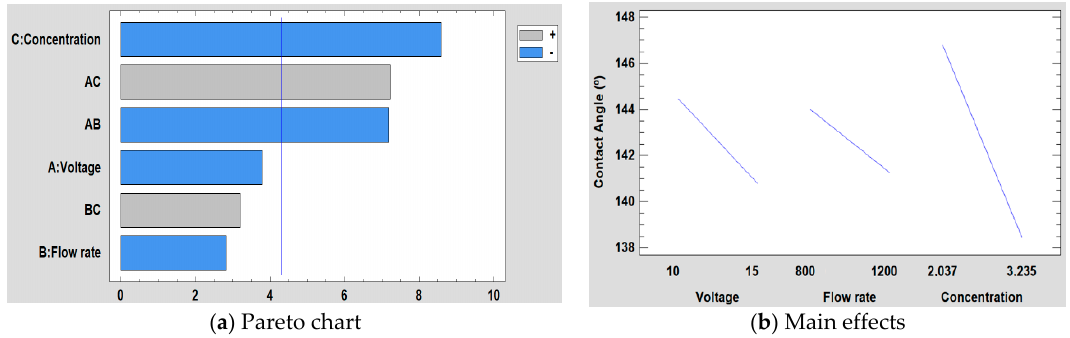
Figure 13. ( a ) Pareto chart and ( b ) the main effects on the water contact angle values.